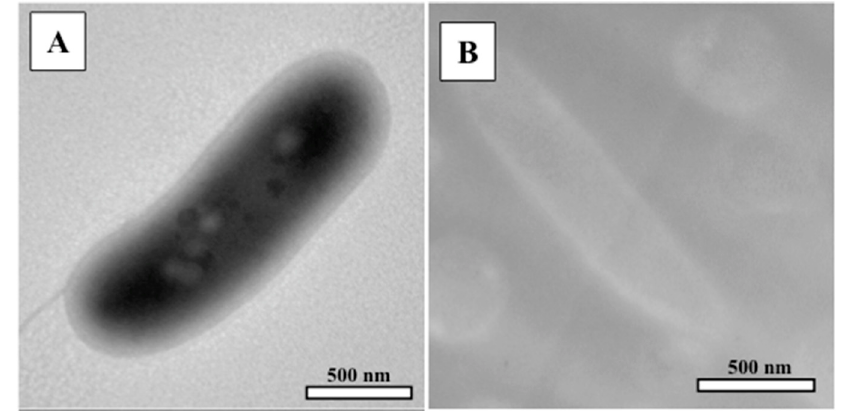
Figure 1. (A ) Whole mount TEM micrograph of an unreacted C. metallidurans cells. Note, the cell envelope is generally electron transparent; ( B ) Unstained, ultra-thin section TEM micrograph of unreacted C. metallidurans . Note the internal detail of cell is lacking because no stain was applied.